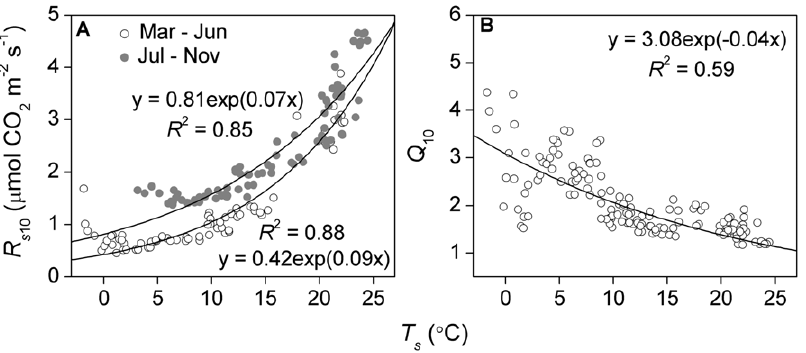
Figure 5. Relationships between soil temperature ( T s ) and (A) daily R s 10 and (B) daily Q 10 . Open circles in (A) are from March to June, closed circles are from July to